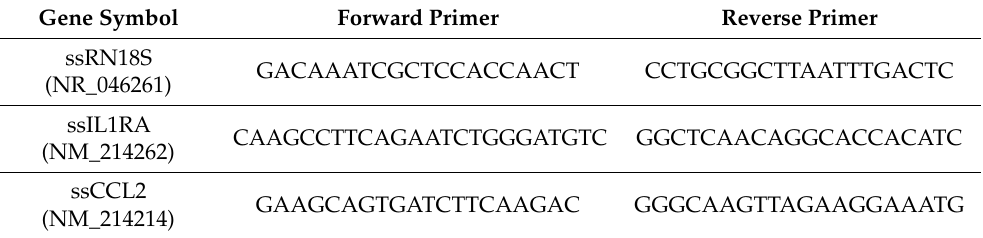
Table 2. Primer sequences for qPCR